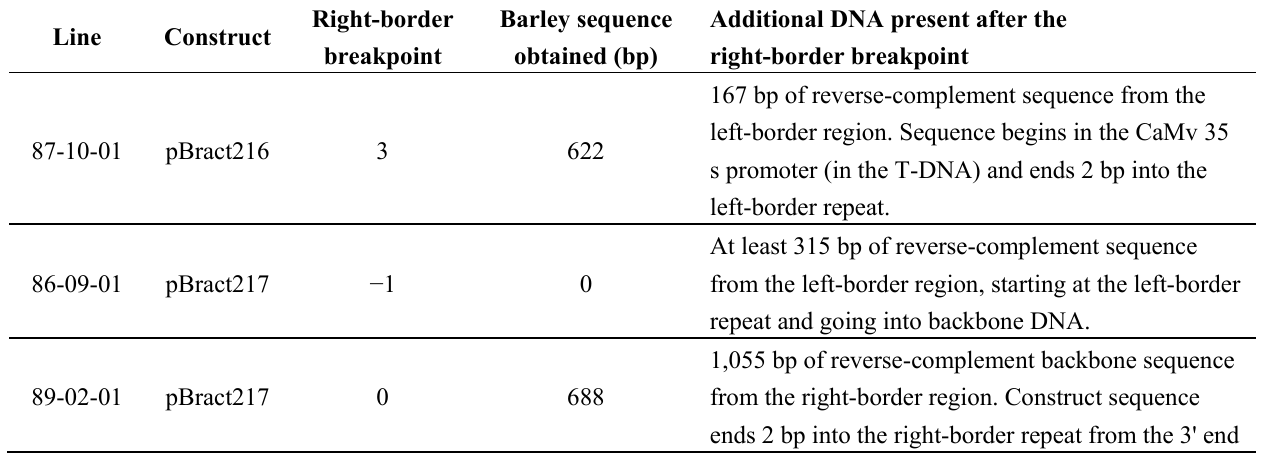
Table 3. Rearrangements present within the plant DNA at the T-DNA right-border. Right-border Barley sequence Additional DNA present after the Line Construct breakpoint obtained (bp) right-border breakpoint 167 bp of reverse-complement sequence from the left-border region. Sequence begins in the CaMv 35 87-10-01 pBract216 3 622 s promoter (in the T-DNA) and ends 2 bp into the left-border repeat. At least 315 bp of reverse-complement sequence 86-09-01 pBract217 − 1 0 from the left-border region, starting at the left-border repeat and going into backbone DNA. 1,055 bp of reverse-complement backbone sequence 89-02-01 pBract217 0 688 from the right-border region. Construct sequence ends 2 bp into the right-border repeat from the 3'